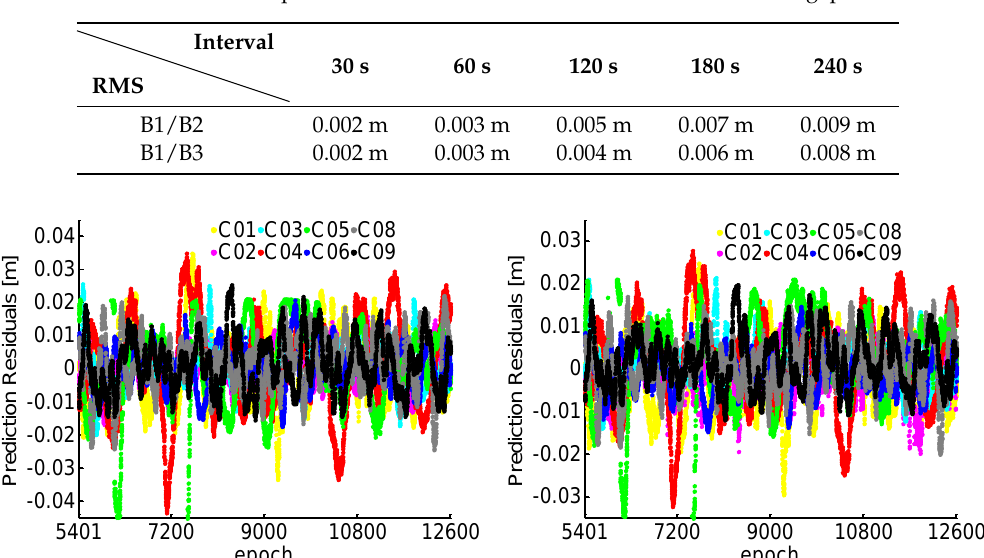
Table 2. RMS of prediction residuals based on TRIM in different data gaps.